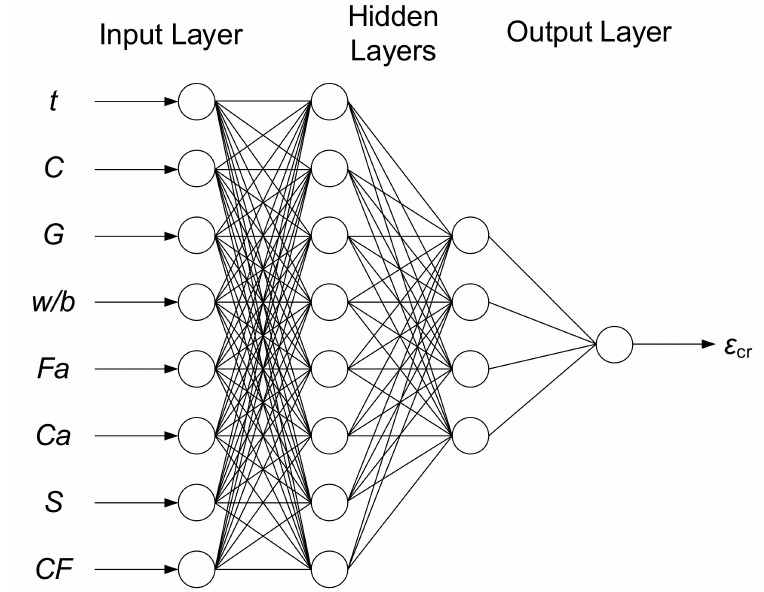
Figure 5. Optimum structure of the Artificial Neural Network